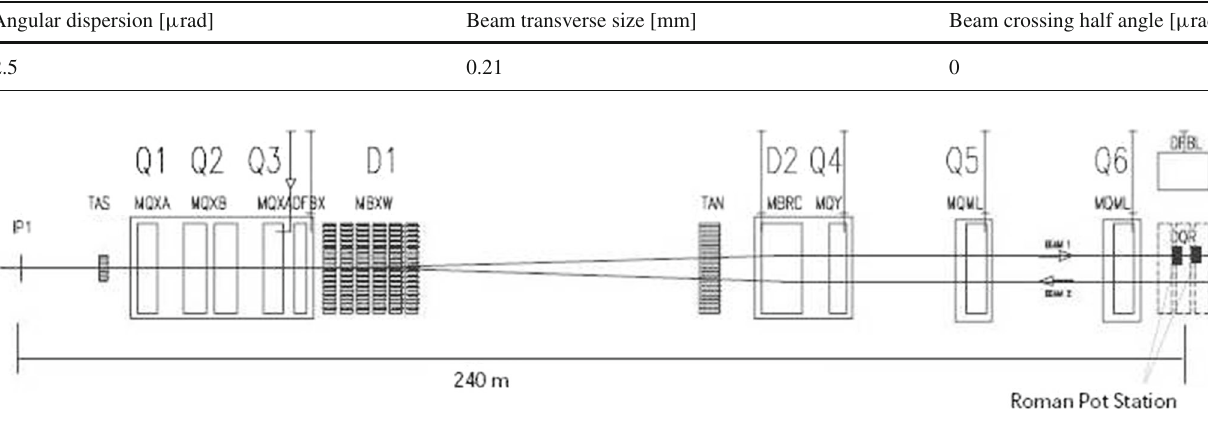
Fig. 2 The LHC magnetic